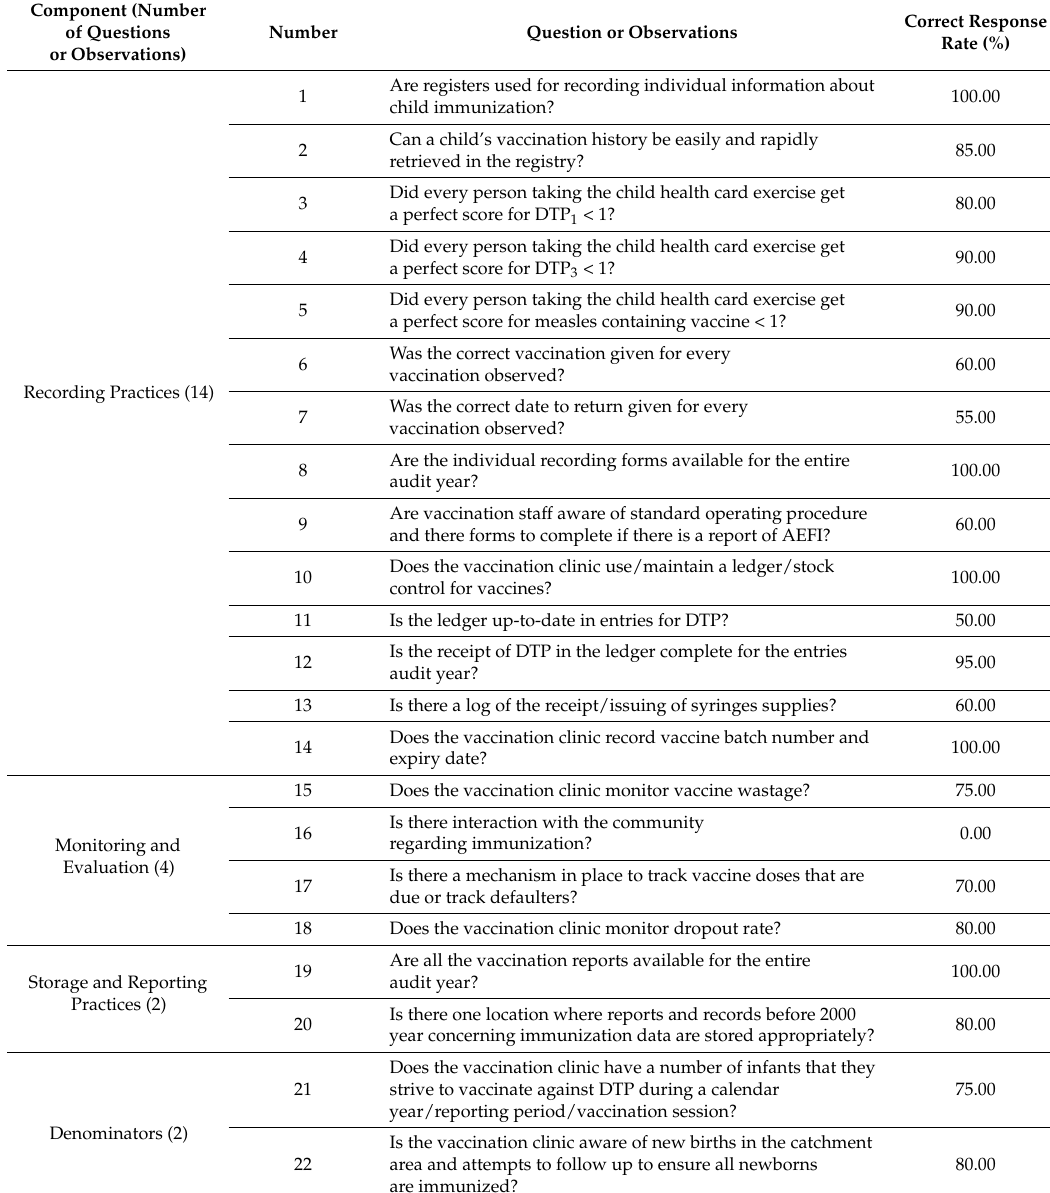
Table 3. Questions or observations for QI evaluation at the vaccination clinic